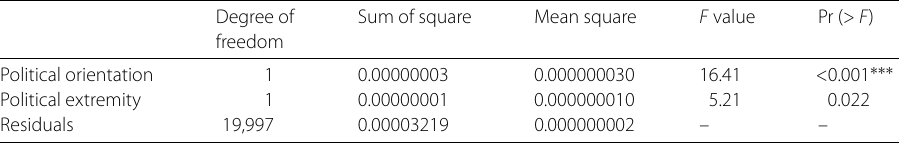
Table 12 ANOVA results to test for correlation of political orientation and extremity with text-based indicators of fairness Degree of Sum of square Mean square F value Pr (> F ) freedom Political orientation 1 0.00000003 0.000000030 16.41 <0.001 ∗∗∗ Political extremity 1